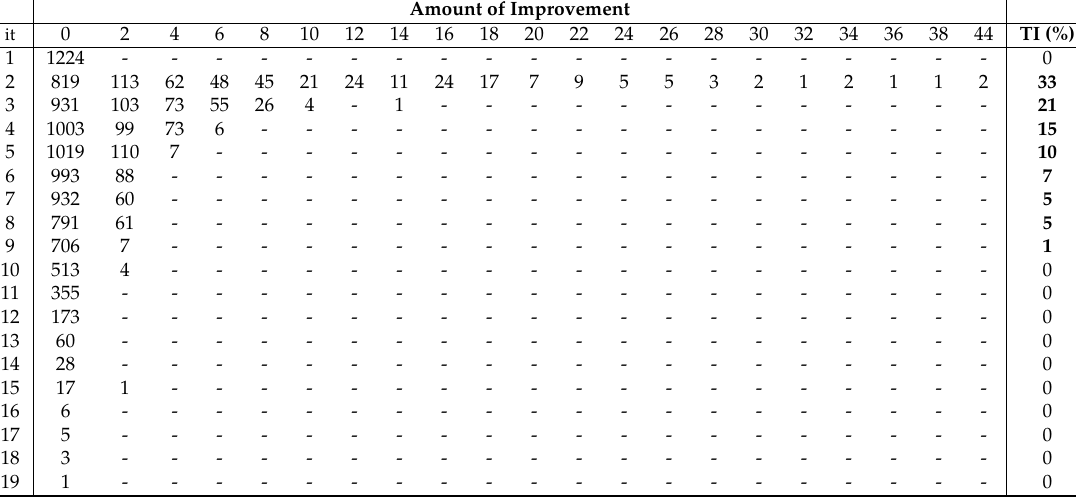
Table 4. Table of number of improvements per iteration for the polblogs network, α =